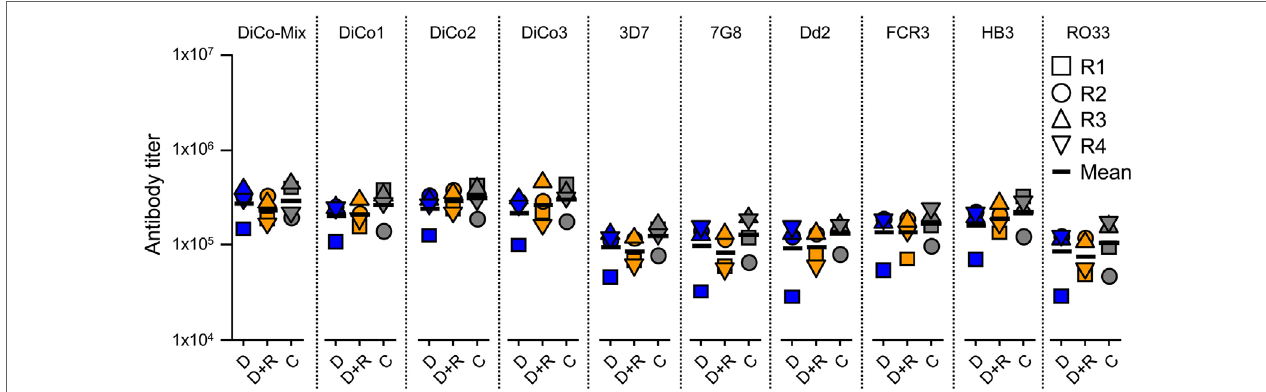
FigUre 2 | Determination of antibody titers in the serum samples. Four rabbits (R1–R4) in each group were immunized using a one prime (day 0) and two boost (day 28 and day 56) immunization schedule and the serum samples were collected on day 70. The antibody titers were assessed by direct-coating enzyme-linked immunosorbent assay using the DiCo-Mix and single DiCo variants as well as six different Plasmodium falciparum apical membrane antigen 1 alleles as coating antigens (indicated above each lane). D: group of rabbits that received 50 µg DiCo-Mix; D + R: group of rabbits that received 50 µg DiCo-Mix and 50 µg of Pf Ron2L peptide at different injection sites; C: group of rabbits that were immunized with the DiCo– Pf Ron2L complex formed by mixing 50 µg of DiCo-Mix with 50 µg of Pf Ron2L. To facilitate complex formation, the DiCo– Pf Ron2L mixture was incubated for 30 min at room temperature before formulation with the adjuvant and immunization. The end-point titers were defined as the highest dilution that gave double the value of the background (pre-immune